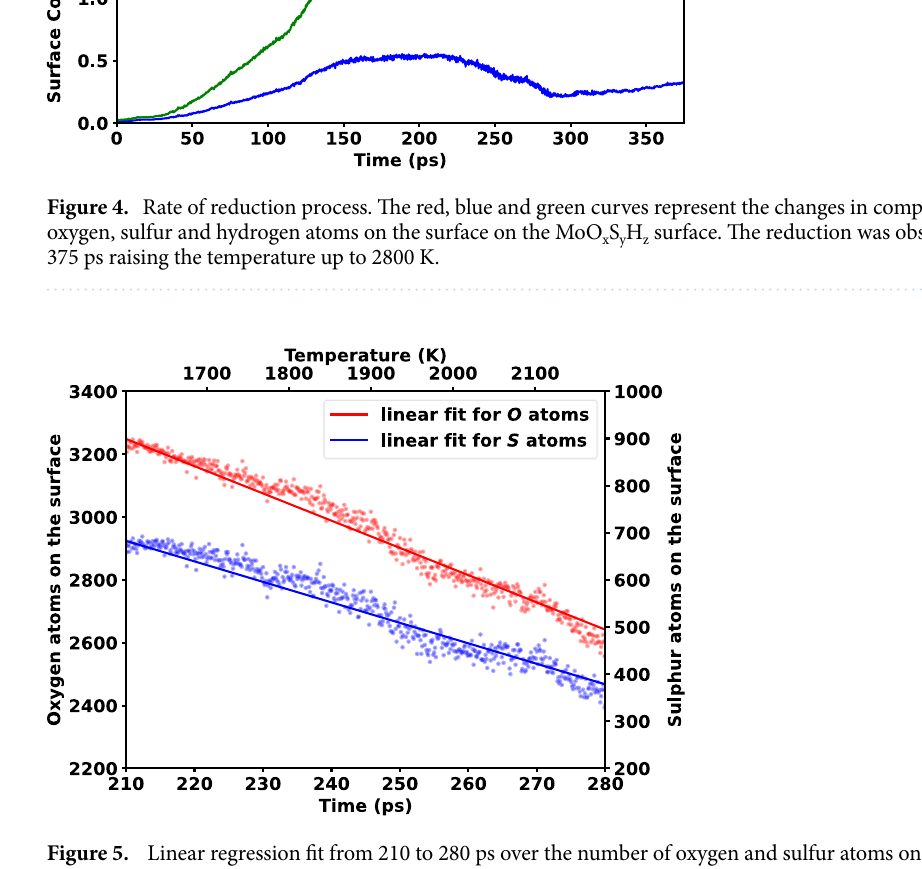
Figure 5. Linear regression fit from 210 to 280 ps over the number of oxygen and sulfur atoms on the MoO x S y H z surface. Here, blue and red lines represent the linear fit and dotted spheres represent the number of sulfur and oxygen atoms,